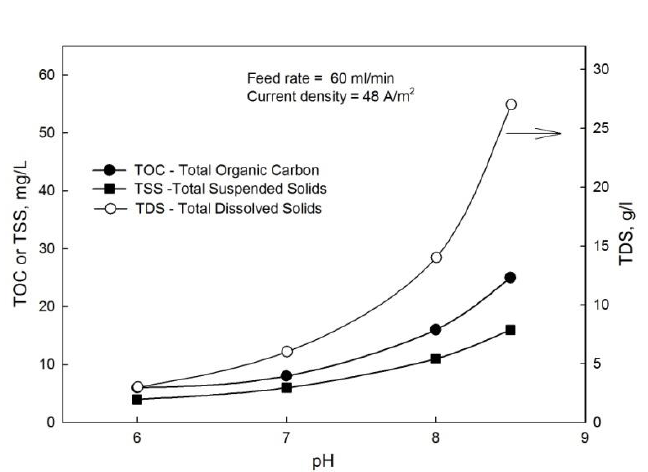
Figure 5. Effect of pH on residual